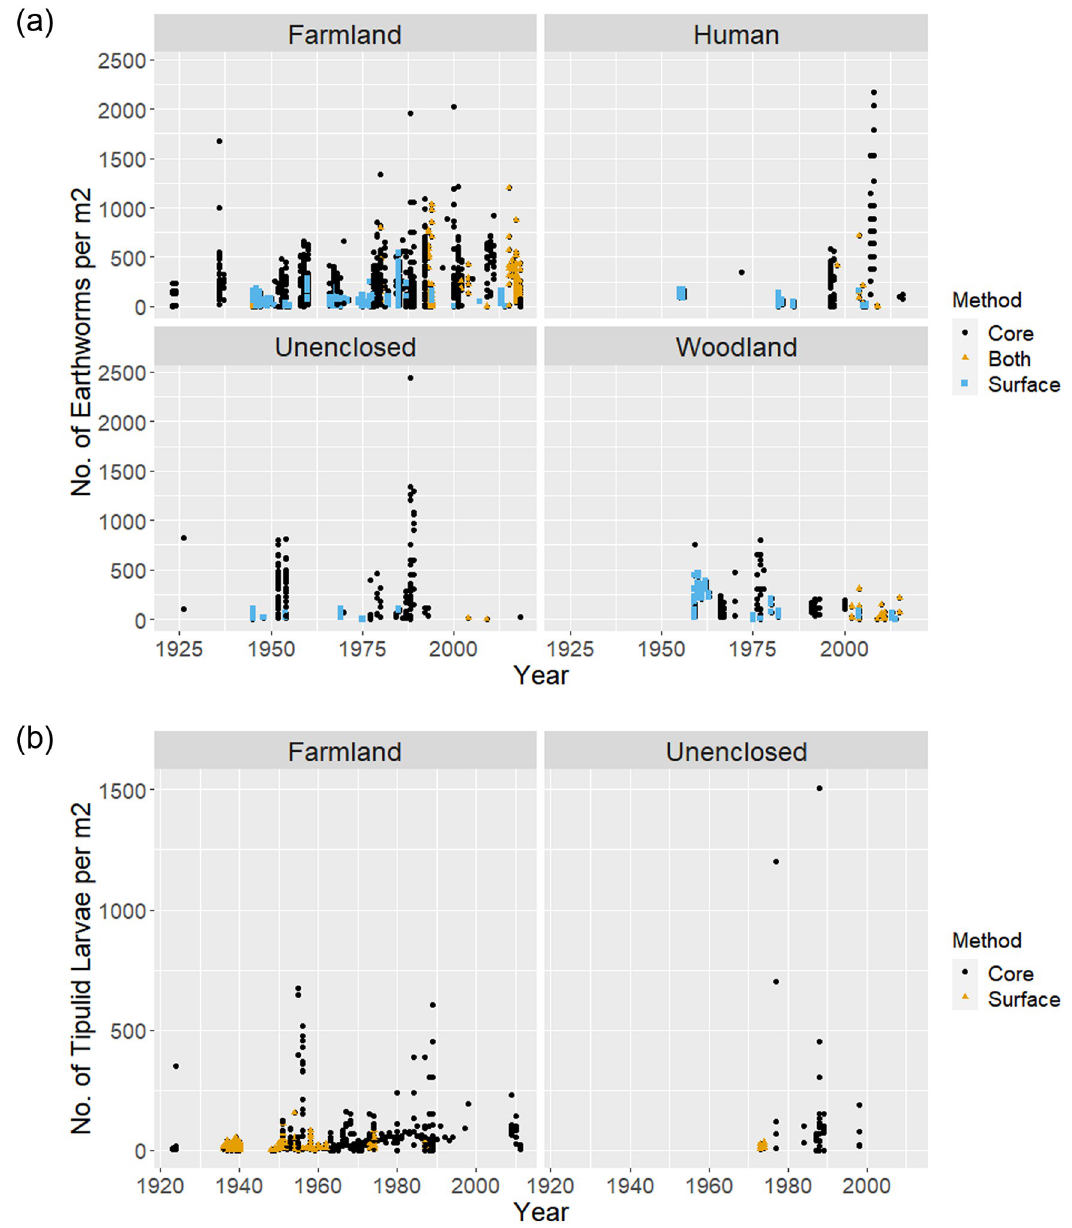
Fig 2. The temporal spread of a) earthworm data and b) tipulid data. Plotted per m 2 across the Broad_Habitat categories and coloured by the Broad_Method categories. Sufficient tipulid data existed for analysis of unenclosed and farmland habitats